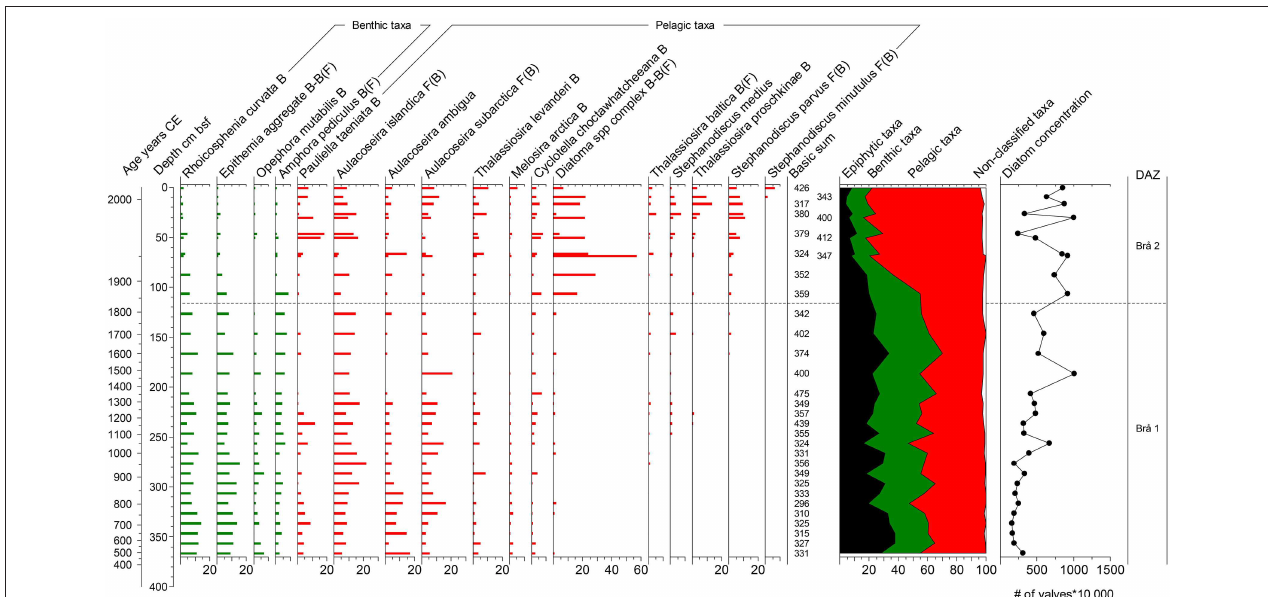
FIGURE 5 | Diatom diagram for the site Bråviken. Taxa are grouped into benthic and pelagic taxa and plotted in order of first appearance. The linear scale is a depth scale and the secondary scale is an age scale in calendar years CE. The summary diagram shows all taxa grouped by life-form. The epiphytes constitutes a part of the benthic community. Diatom concentration are given in # of valves *100,000 per gram dry weight sediment. Salinity distribution (F = Freshwater; B = Brackish; BF = Brackish-freshwater; BM = Brackish-marine) from Snoeijs (1993–1998).